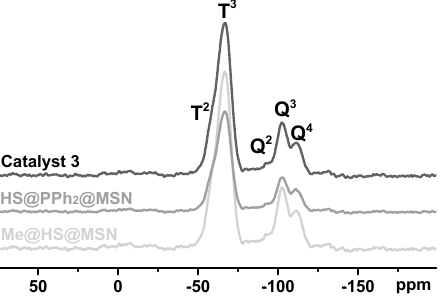
Figure 3. The solid-state 29 Si MAS NMR spectrum of catalyst 3 .